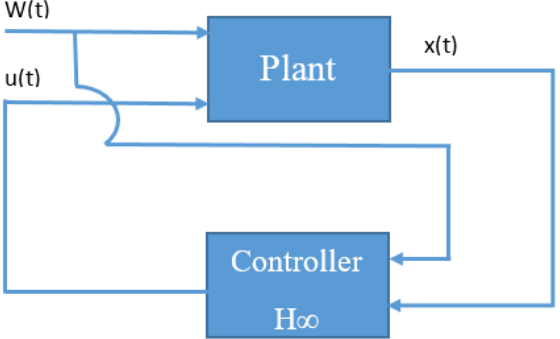
Figure 6. H ∞ controller with full control.